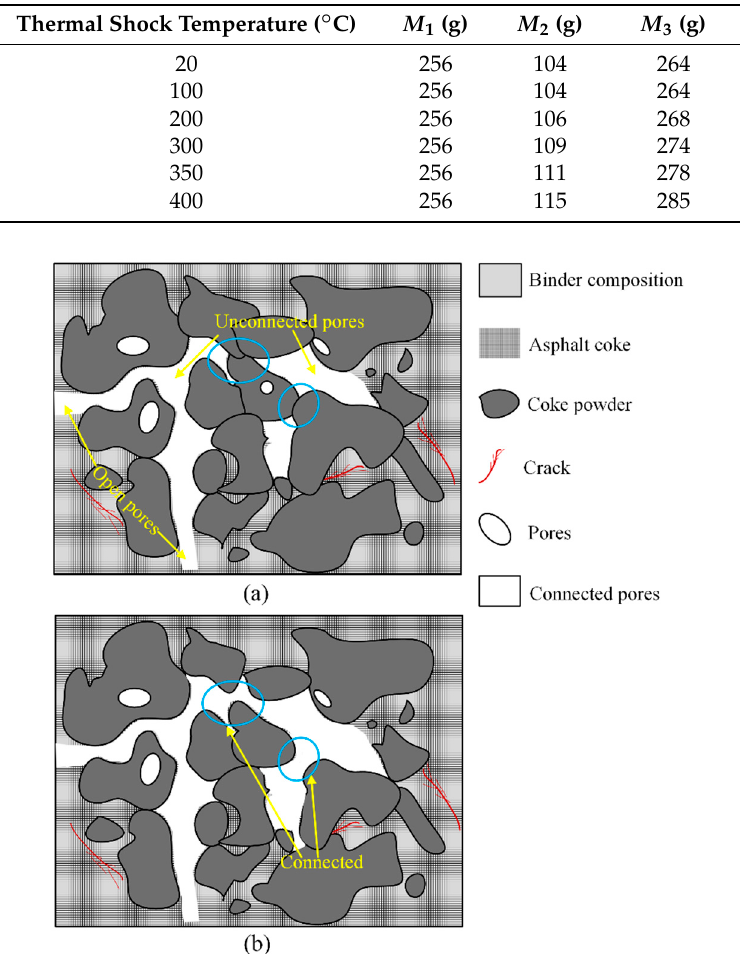
Figure 2. Different types of micropore ( a ) before temperature increase and ( b ) after temperature